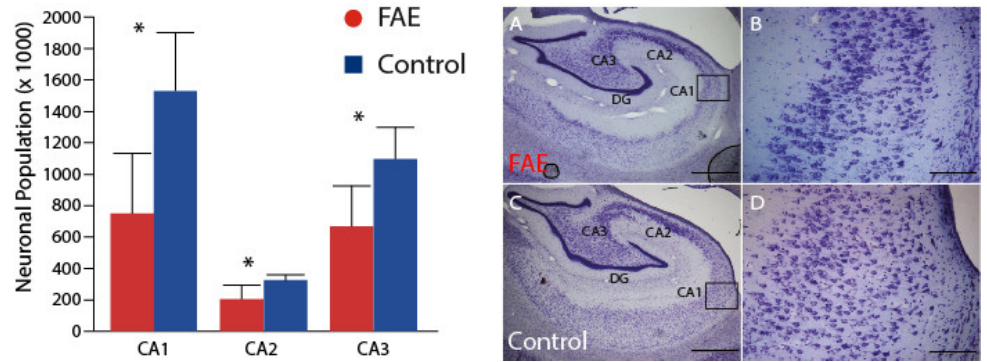
Figure 1. Hippocampal Neuronal Population. FAE subjects, as a group, had significantly lower neuronal populations in hippocampal regions CA1, CA2 and CA3, despite the inclusion of subjects exposed to lower levels of ethanol during gestation. Representative histological sections from FAE ( A , B ) and control ( C , D ) subjects demonstrate a thinned and sparsely populated pyramidal neuronal layer. * p < 0.05 FAE vs. control. ( A , C ) scale bar = 1 mm taken at 2.5 magnification; ( B , D ) are taken from the CA1 region (inset box) at 10× magnification scale bar = 100 µm.